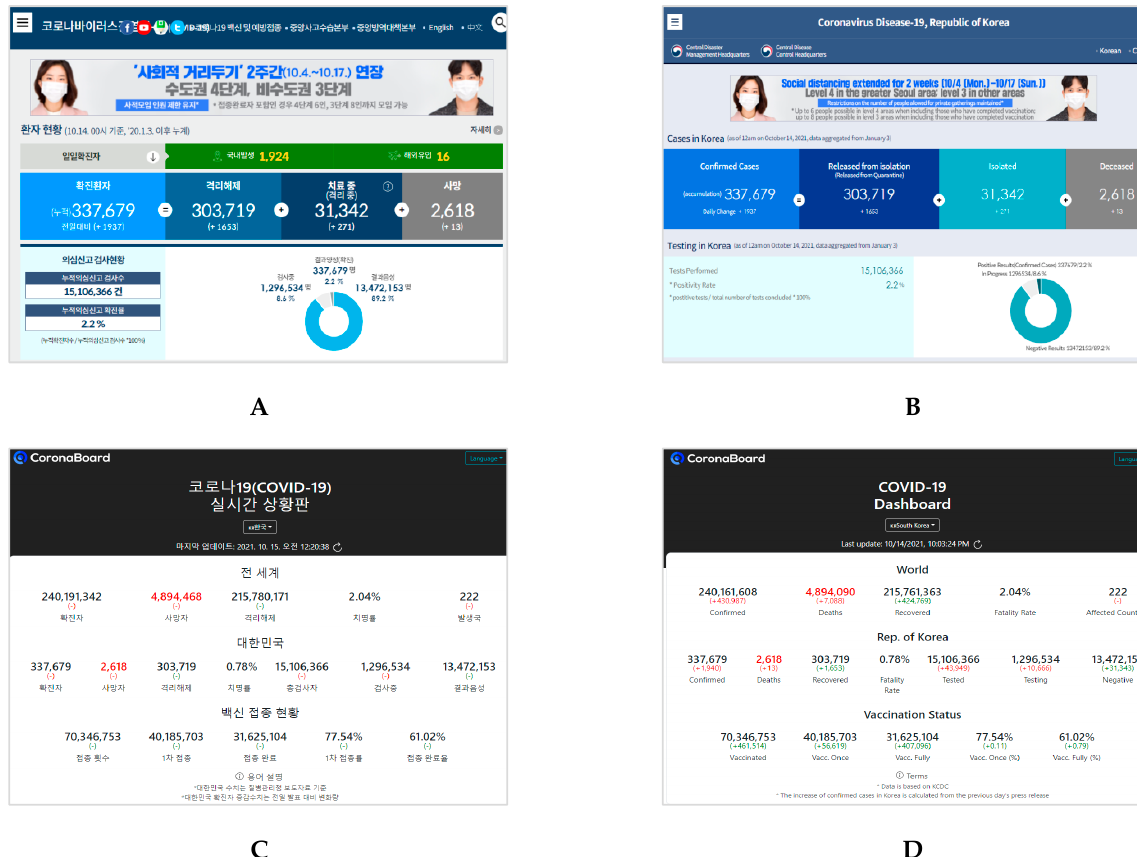
Figure 1. Homepages of the two dashboards in Korean (left) and English (right) for South Korea: ( A ) Coronavirus Disease-